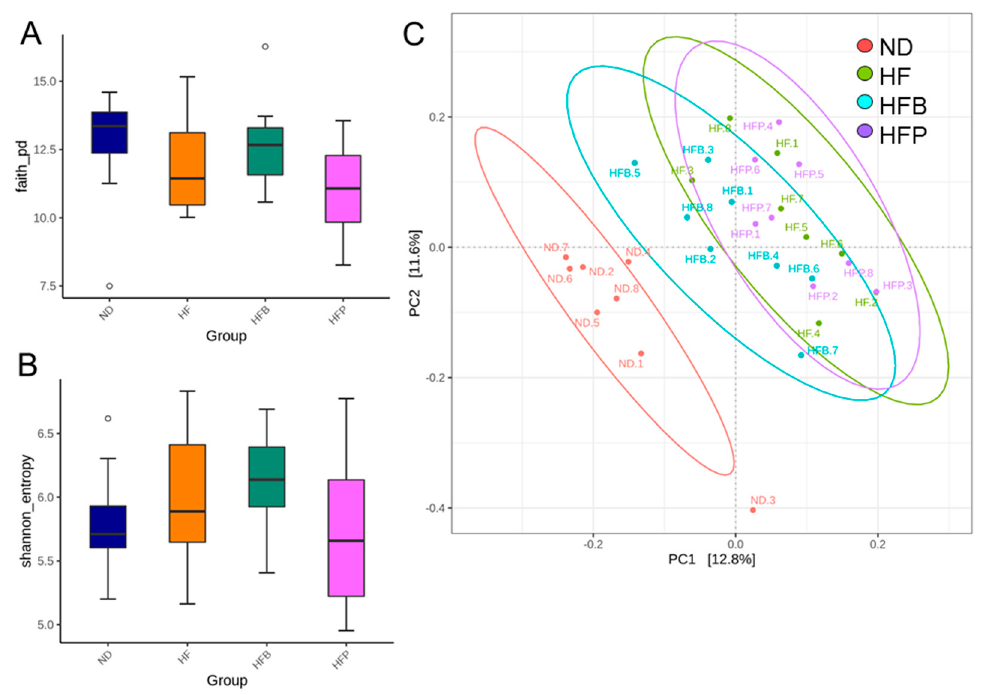
Figure 4. α -diversity measures: ( A ) Faith’s phylogenetic diversity (PD) index and ( B ) Shannon index. ( C ) β -diversity analysis using principal coordinate analysis (PCoA). Each dot denotes the microbiota for a given sample, and the dot color reveals the grouping for that sample. n = 8/group.